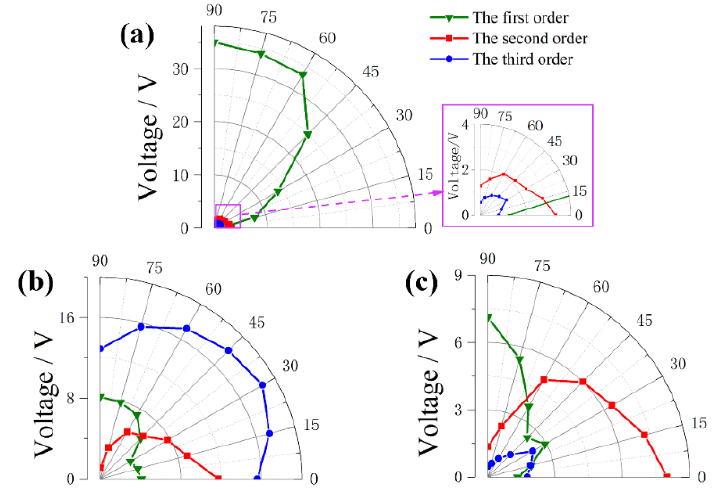
Figure 10. Open-circuit voltage versus frequency under horizontal excitation with different β .